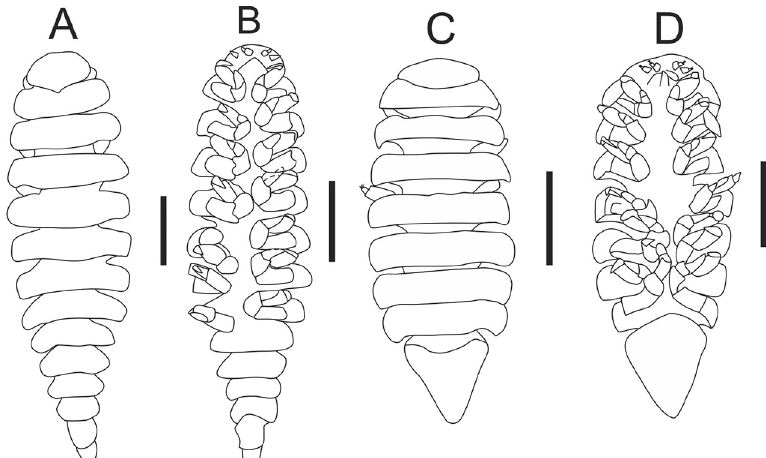
Figure 3. Anuropodione carolinensis Markham, 1974 (MOUFPE 18874), Potiguar Basin, station #MT–61, 418 m, Rio Grande do Norte, northeastern Brazil. (A) Male dorsal; (B) male ventral; (C) male with pleomere fused in dorsal view; (D) male with pleomere fused in ventral view. Scale bar = A–E, 1